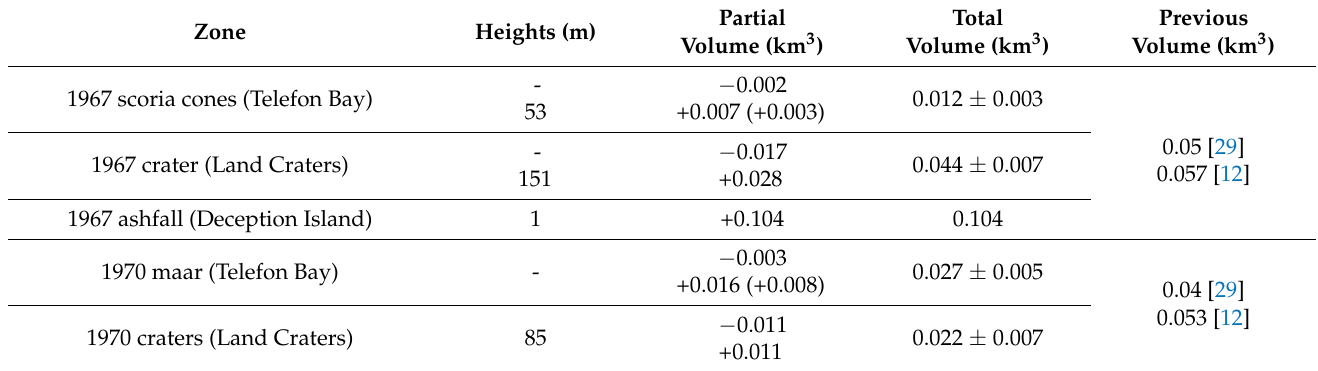
Table 2. The comparison of erupted ash calculated volumes. The underwater volume was estimated for an average depth of about 10 m, shown in parentheses. The estimated volume uncertainty is from height uncertainty and land area. Negative values represent excavated erupted ash, and positive values represent deposited erupted ash. Partial Total Previous Heights (m) Volume (km 3 ) Volume (km 3 ) Volume (km 3